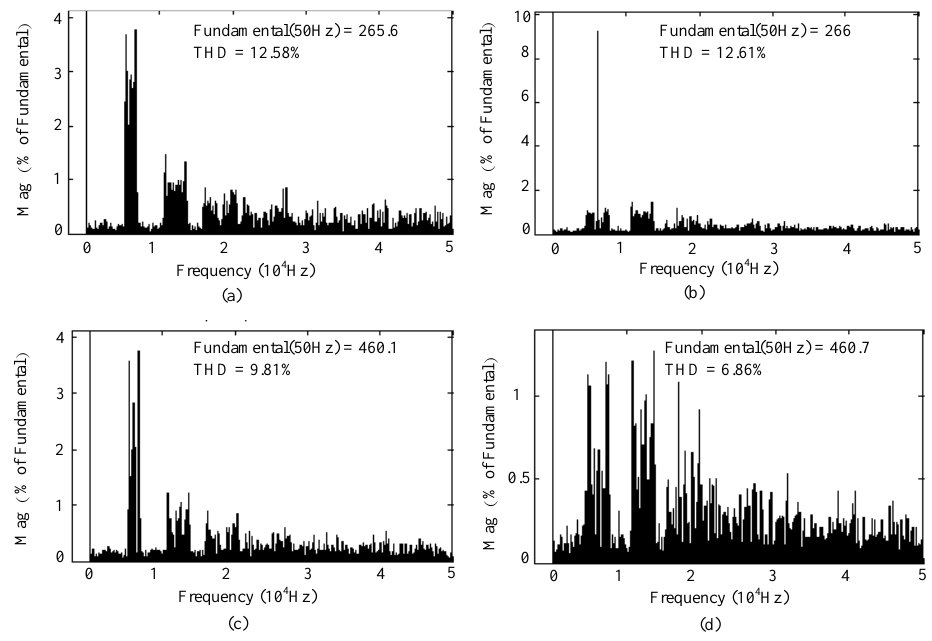
Figure 8. Spectrum of phase voltage and line voltage for PS-PWM and the optimized new strategy (Modulation depth, M = 0.95): ( a ) Spectrum of phase voltage for PS-PWM; ( b ) Spectrum of phase voltage for the optimized new strategy; ( c ) Spectrum of line voltage for PS-PWM; ( d ) Spectrum of line voltage for the optimized new strategy.